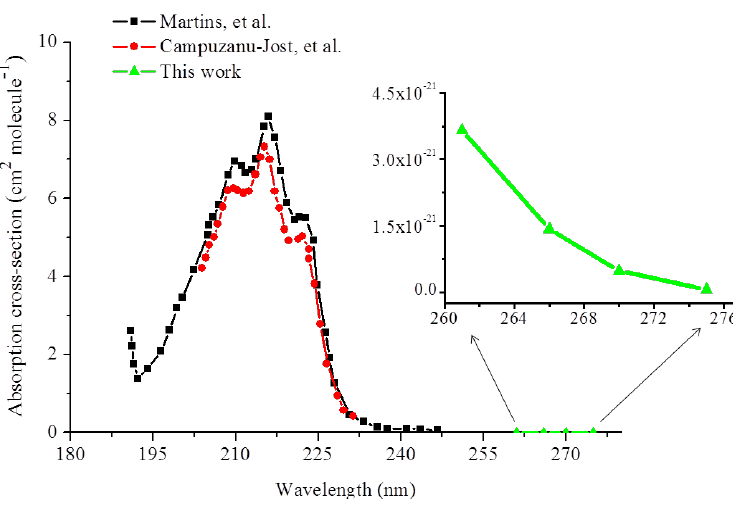
Figure 5. UV absorption profile of isoprene obtained in this work along with the data reported in the literature. The curve denoted by dots shown in the inset is from this